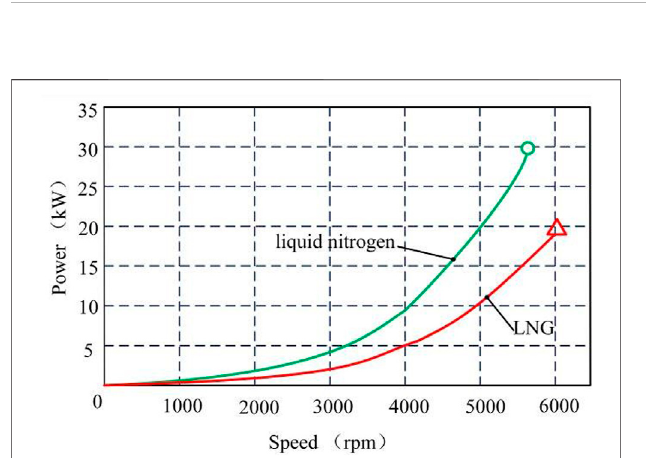
FIGURE 11 | Power curves of the CPMSM when operating in liquid nitrogen and LNG.